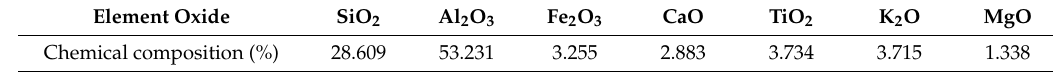
Table 2. Chemical elemental contents in